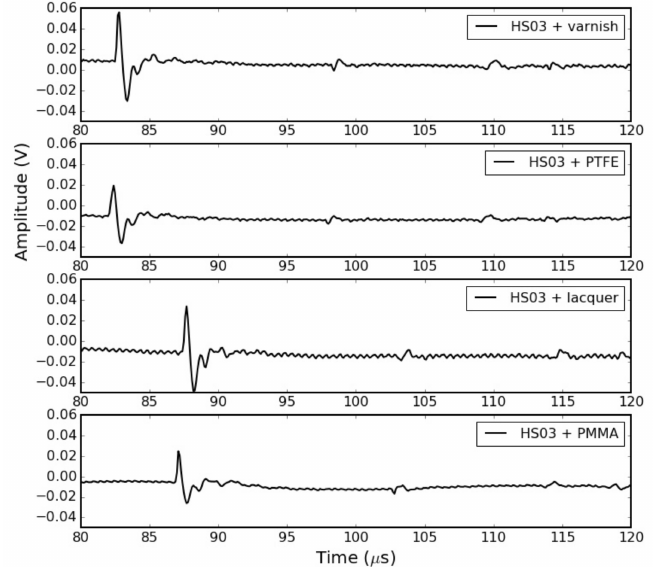
Figure 10. The response in the time domain in pulse-echo mode in water for HS03 transducers with di ff erent coatings (varnish, PTFE, lacquer and